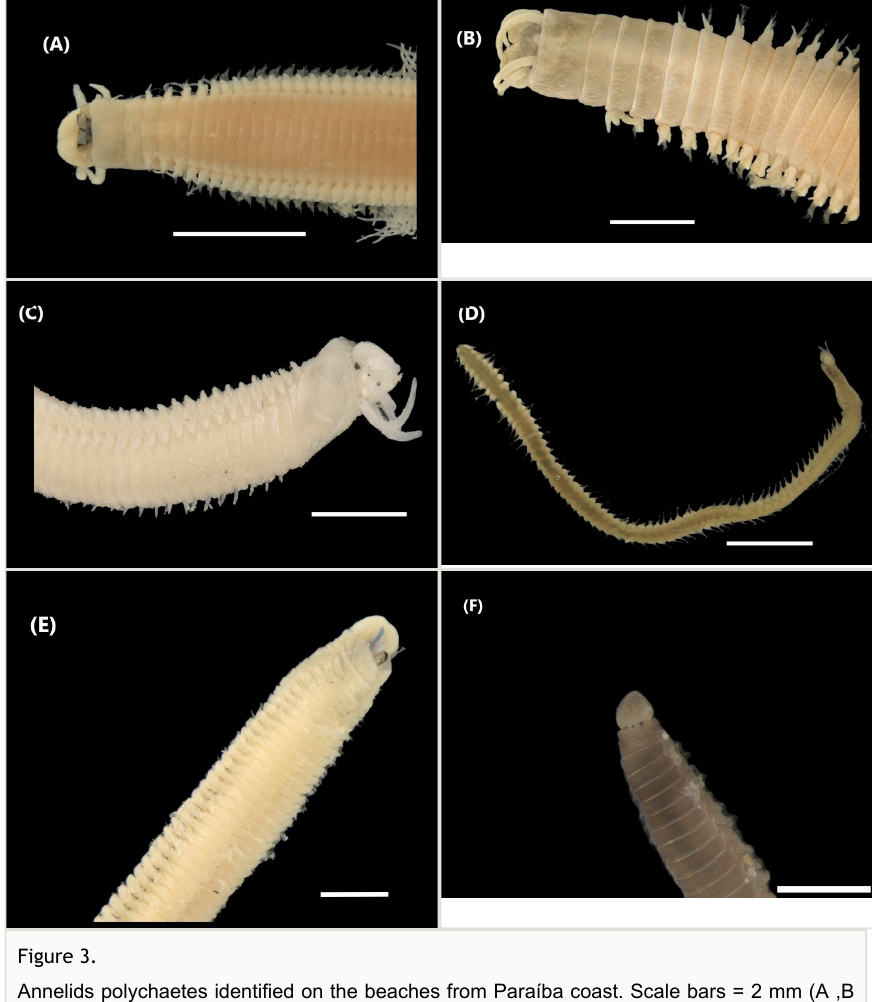
Figure 3. Annelids polychaetes identified on the beaches from Paraíba coast. Scale bars = 2 mm (A ,B and D), 1 mm (C ,E and F). Photos: (A-F) by Prata,